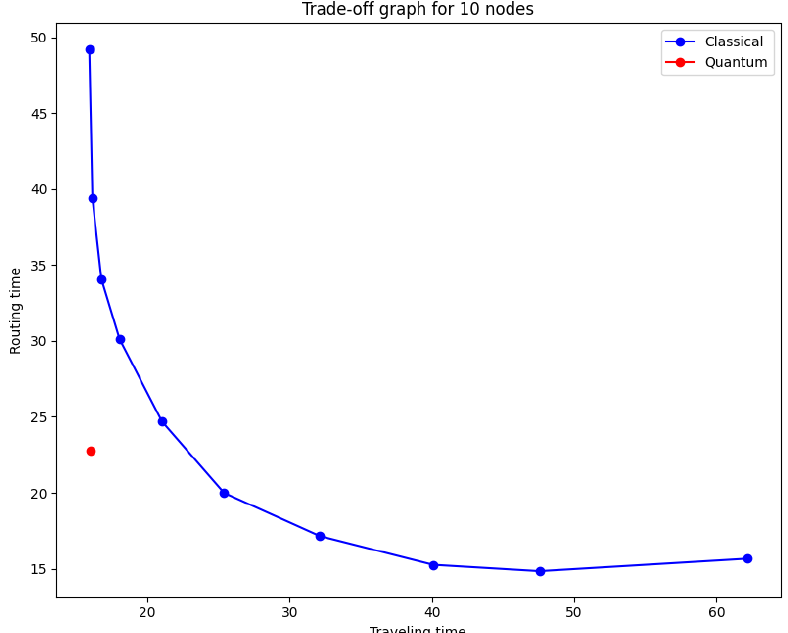
Figure 7. Trade-off barrier broken by quantum protocol. In red the quantum strategy, in blue different mixed classical strategies with p values between 0 and